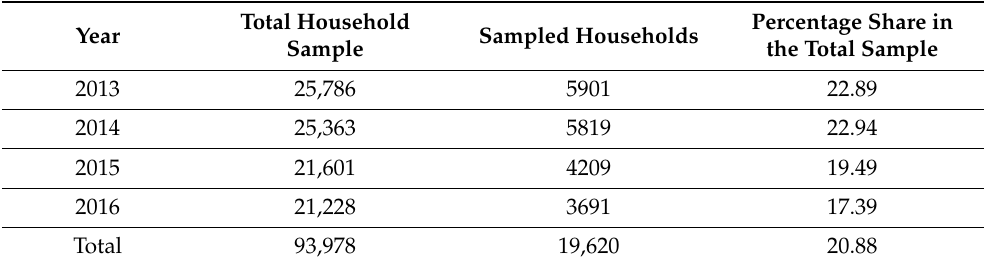
Table 1. Surveyed and sampled households for agricultural development